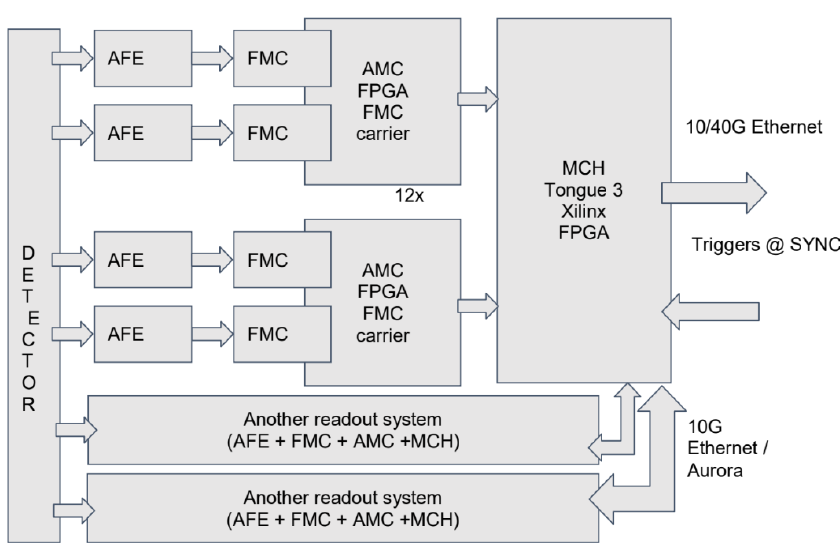
Figure 10. System architecture based on the MicroTCA